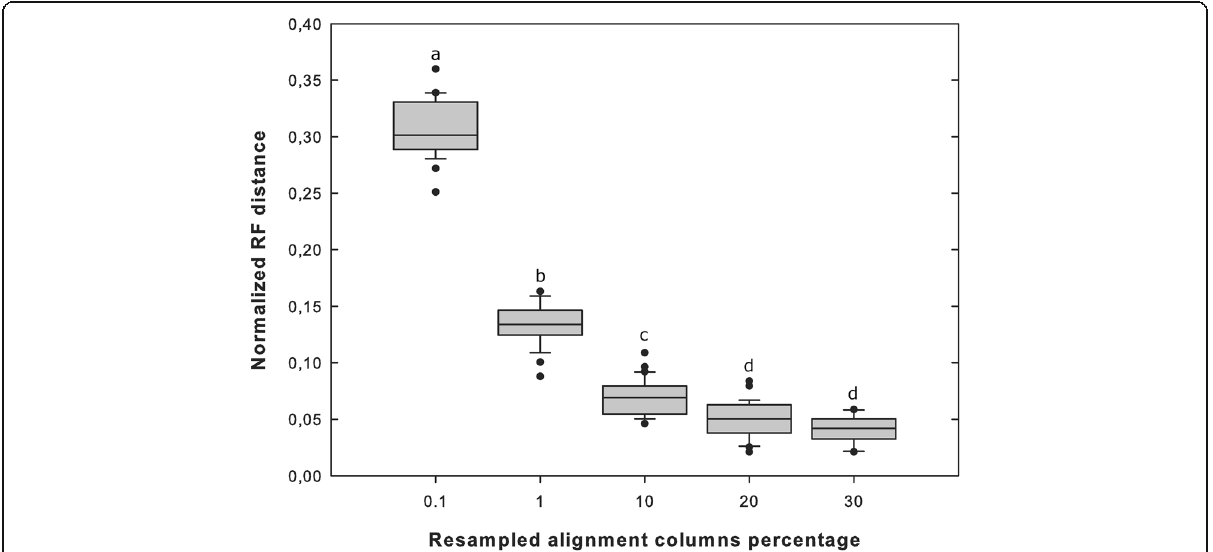
Fig. 3 Distribution of the 30 normalized RF distances from the reference topology for each of the five resampling efforts. Boxes are delimited by the distance between the 25th and 75th percentile; lines inside the boxes show the median value of the distribution; whiskers refer to 10th and 90th percentiles; outliers are marked with black dots. Letters ( a , b , c , d ) are used to label statistical significance; boxes with different letters are significantly different ( p < 0.01) while the same letter indicates no statistical